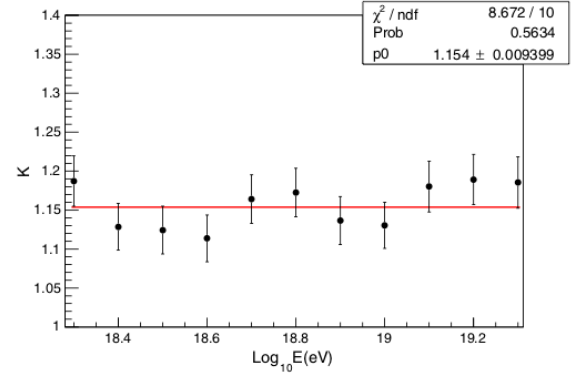
Figure 2. Primary energy dependence of K factor derived using the CONEX one-dimensional MC simulation. The QGSJET II- 04 hadronic interaction model was used. (Figure from [5].)